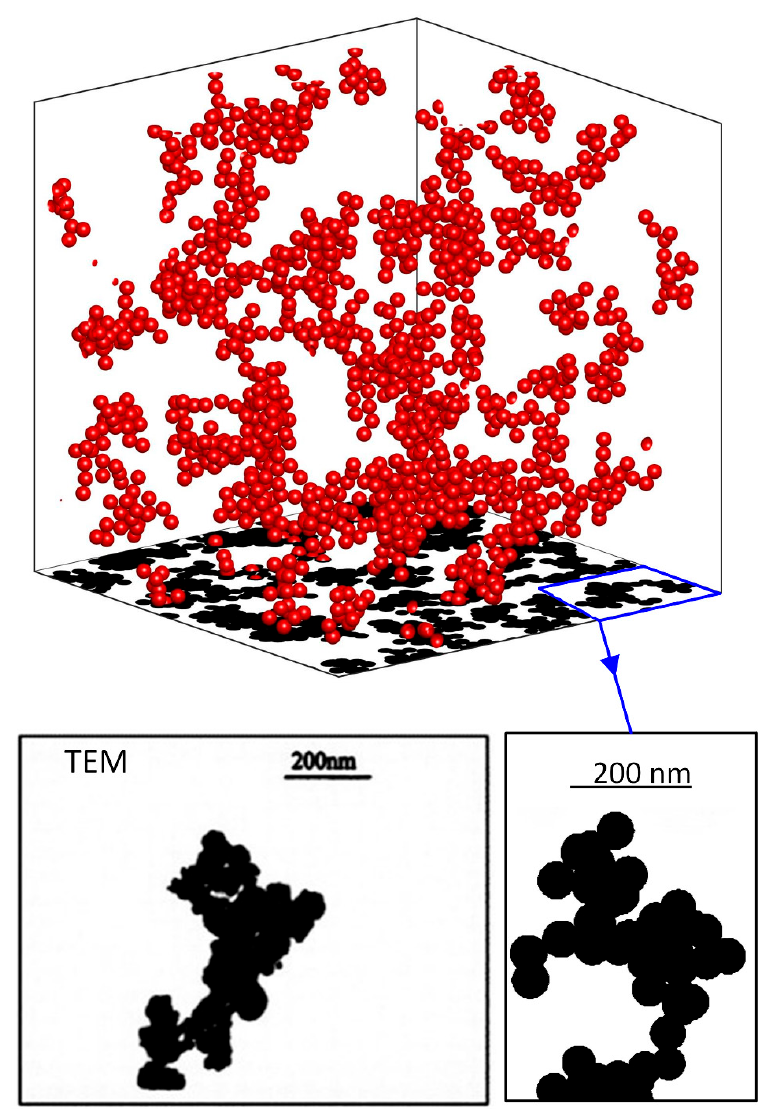
Figure 3. Upper: Simulation example with parameters from experimental data and projection on a 2D plane. Bottom: Comparison of the resulting image with an image from an electron microscope (TEM) [10] following [10] .